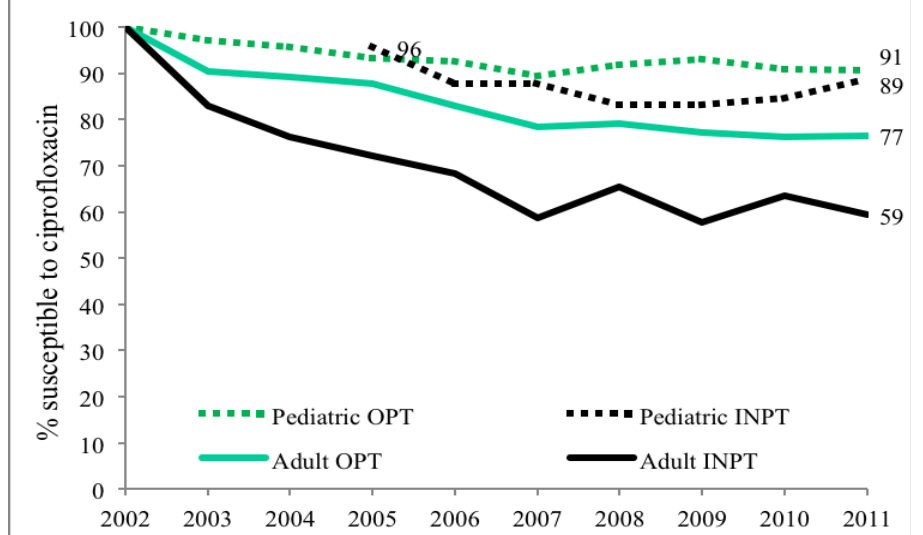
Figure 2. Outpatient and inpatient adult and pediatric ciprofloxacin susceptibility trends for E. coli positive urinary cultures (OPT = outpatient, INPT =